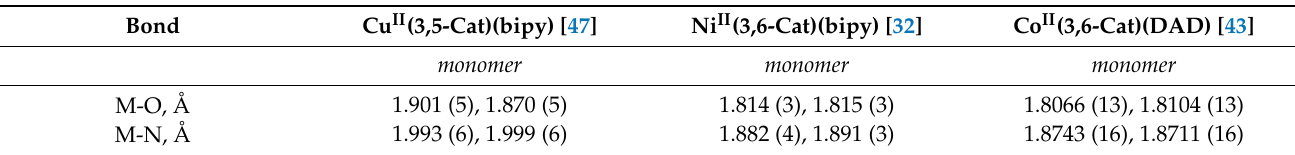
Table 3. Values of “metal-heteroatom” distances in some known monomeric “ α -diimine-M II - catecholate” type